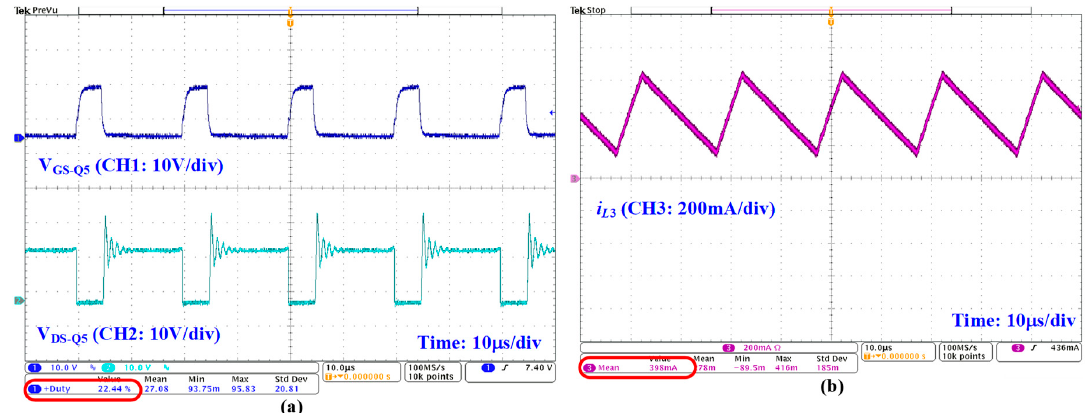
Figure 14. Measured waveforms of PCL 3 with the FDC method: ( a ) switch voltages of V GS-Q5 and V DS-Q5 , ( b ) inductor current of i L 3 .